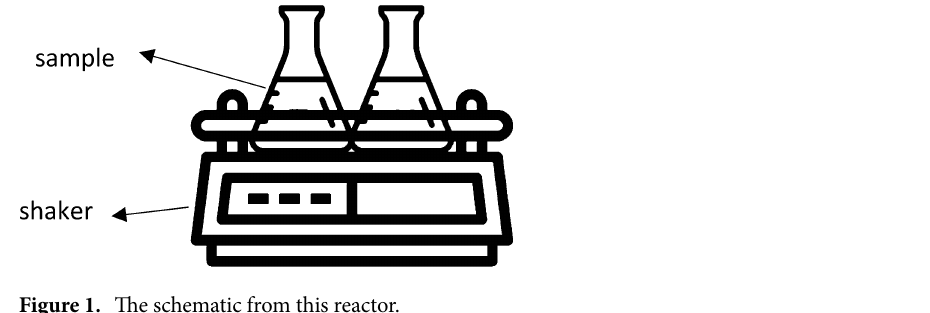
Figure 1. The schematic from this